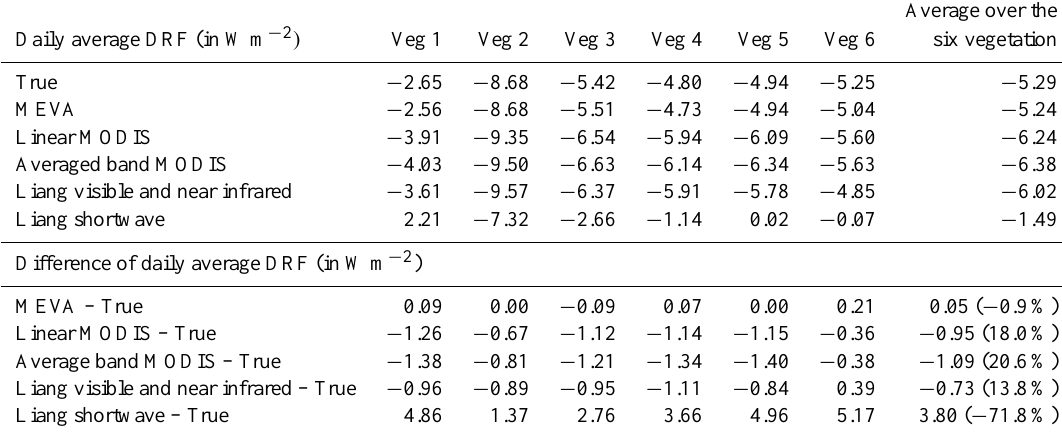
Table 6. The calculated daily average aerosol DRF at equator and in equinox (in Wm − 2 ; from 0.3 to 2.35µm) with different approaches to the surface reflectance spectrum. The last column presents the average aerosol forcing over the six vegetation types. Bold numbers indicate the differences in daily averaged aerosol forcing associated with different approaches; the numbers in parentheses represent the ratio of these differences to the results calculated with “true”. Other parameters used in the simulation include SSA (at 0.55µm) of 0.89 and AOD (at 0.55µm) of